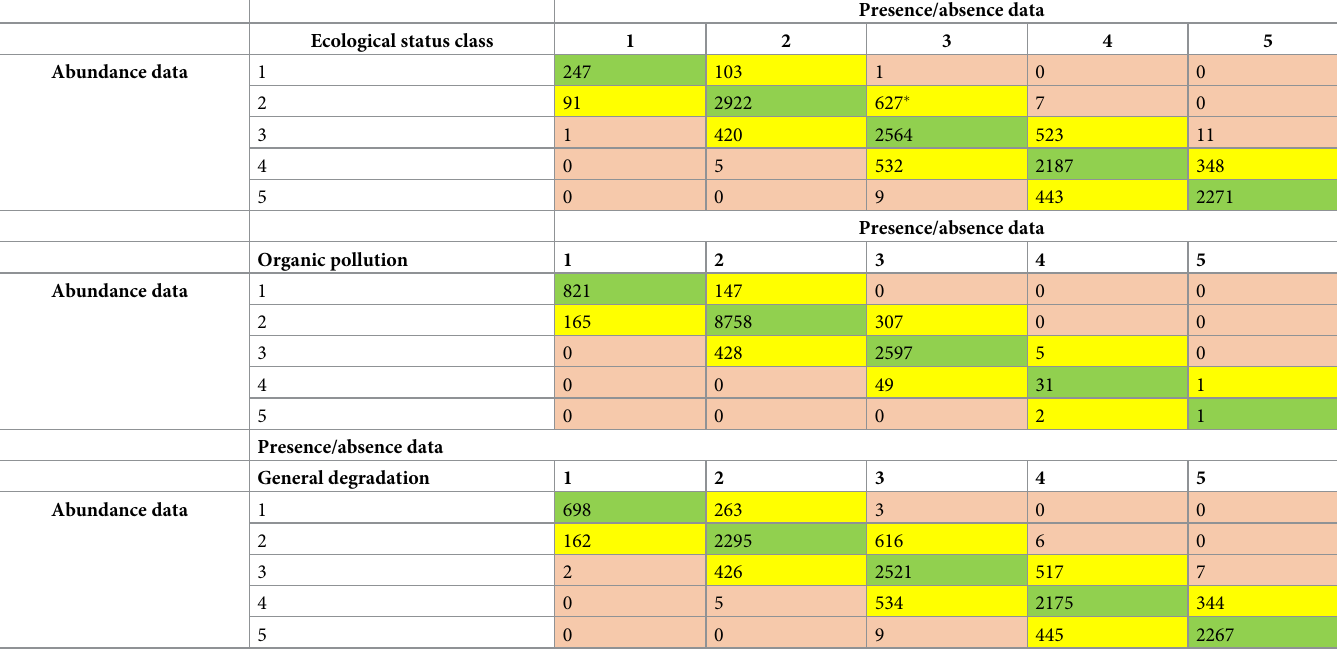
� indicates the number of stream assessments that would fall outside the threshold criterion (i.e. at least ESC = 2) after transformation. The high deviation is due to stream type